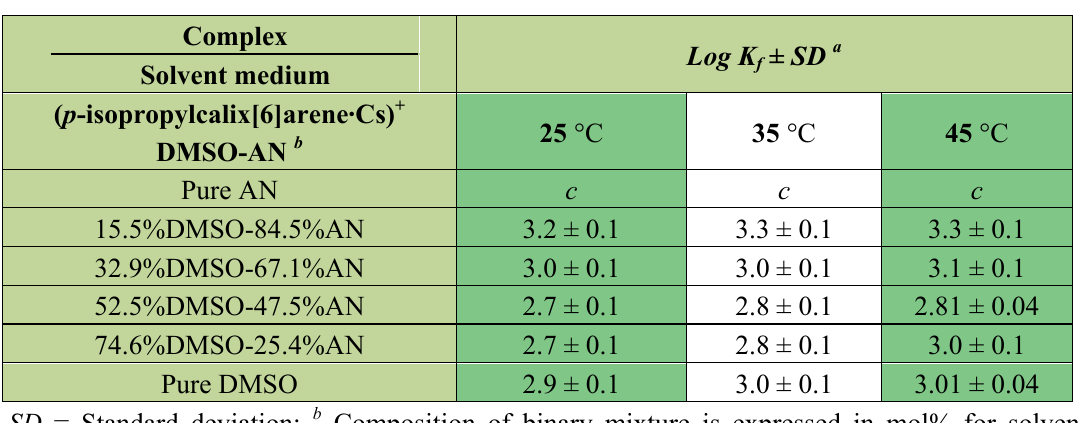
Table 2. Log K values of ( p -isopropylcalix[6]arene·Cs) + complex in DMSO-AN binary f mixed solvent at different